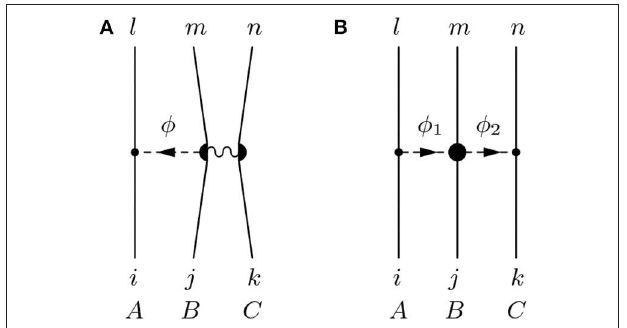
FIGURE 9 | Generic meson-exchange diagrams. The wiggly line symbolized the four-baryon contact vertex, to illustrate the baryon bilinears. (A) Generic one-meson exchange diagram. (B) Generic two-meson exchange